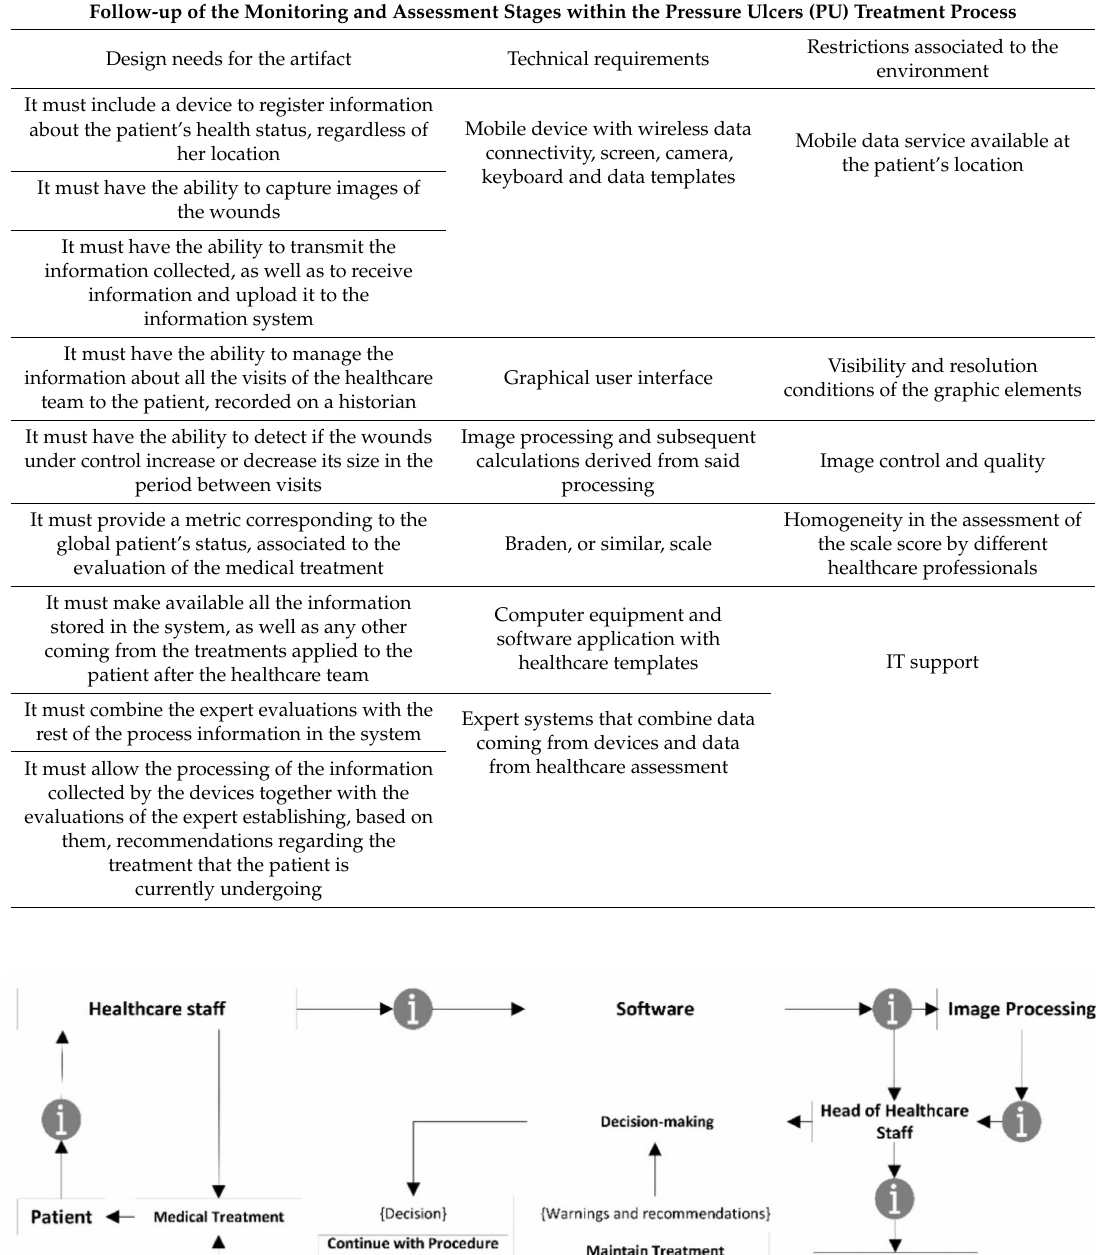
Table 1. Design needs, requirements, and the corresponding restrictions.